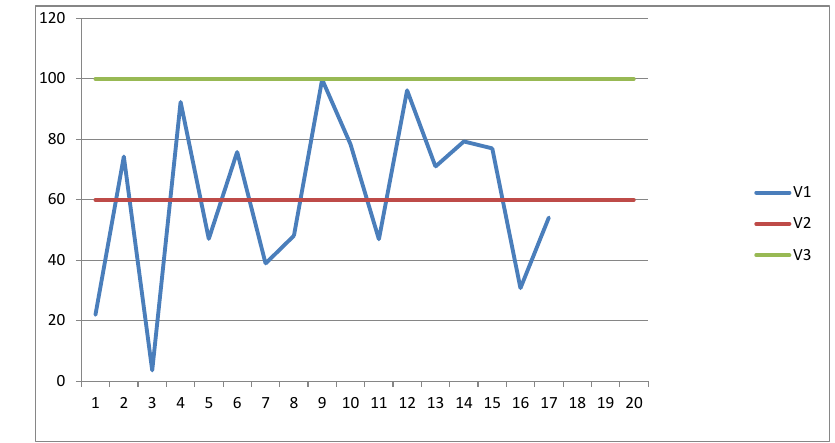
Figure 7. The calculated routes in scenario 1, starting from the blue point to the green point.